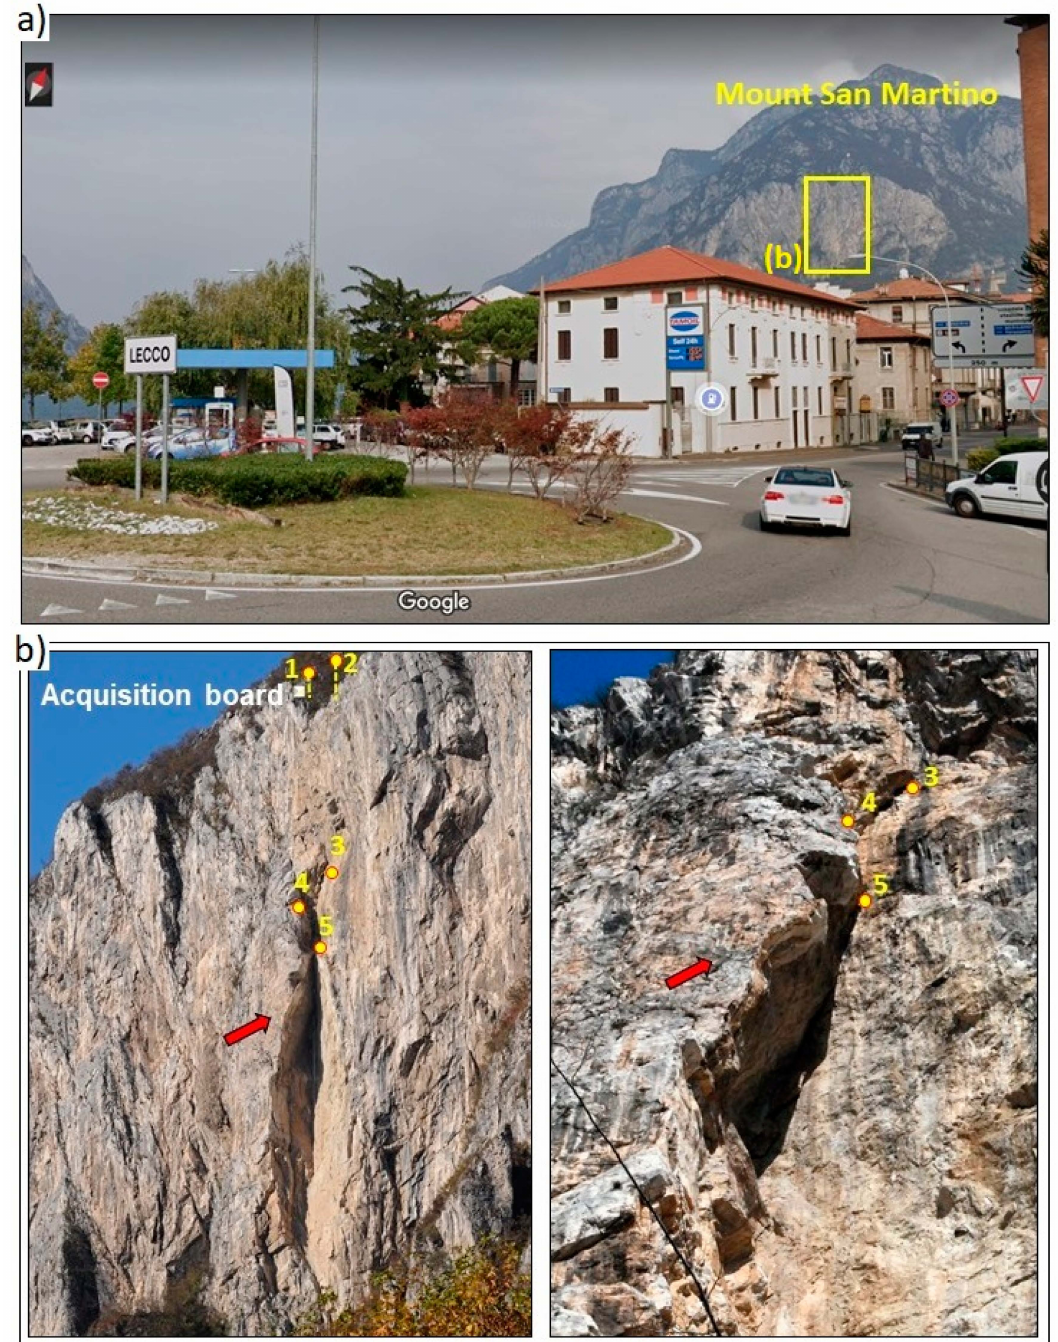
Figure 1. The study site in the southern part of Mount San Martino. ( a ) View of Mount San Martino from Lecco city. The yellow rectangle indicates the monitored area where the monitoring network was deployed. ( b ) Rock face with the positions of the five geophones and the acquisition board of the microseismic monitoring system. The red arrow indicates the partially detached pillar below Geophone